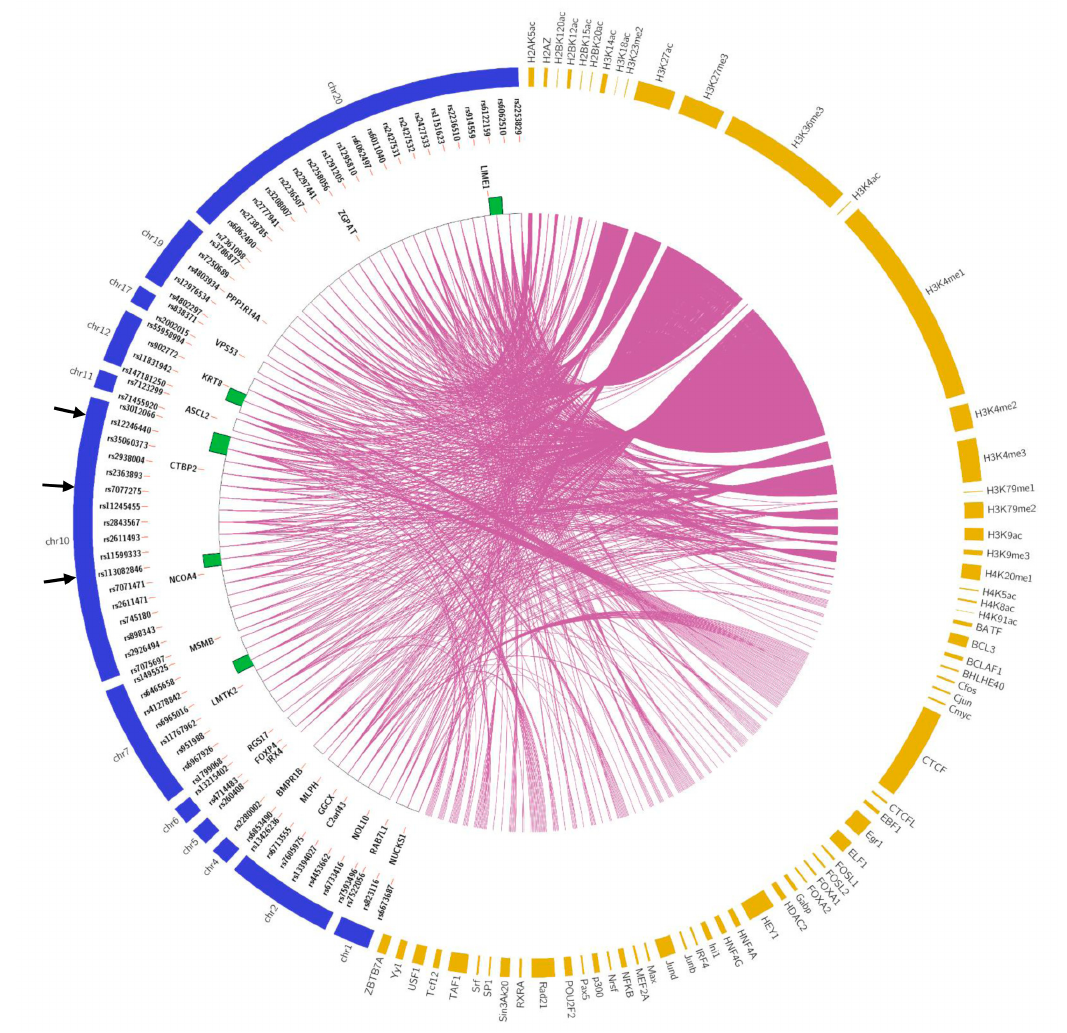
Figure 4. Circos plot showing functional annotations on the 74 promising SNPs. Left semicircle: from outer to inner ring are chromosomes and related SNPs, genes, and MATCH results (putative transcription factor binding sites); right semicircle: histone and transcription factor marks from Regulome DB, HaploReg, SNPnexus, and Variant E ff ect Predictor (VEP). Arrows ( → ) indicate three selected SNPs for electrophoretic mobility shift assay (EMSA)